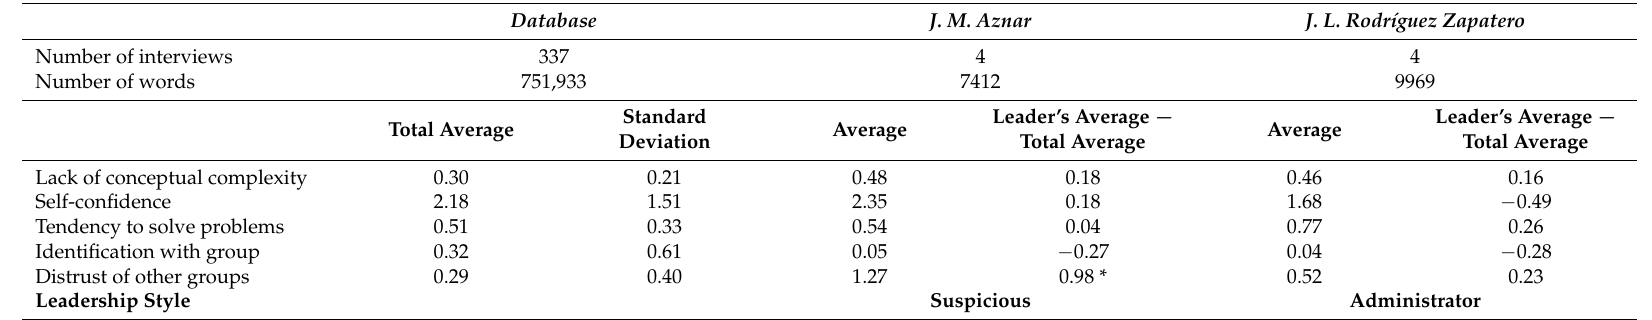
Table 5. Results of Content Analysis: Aznar and